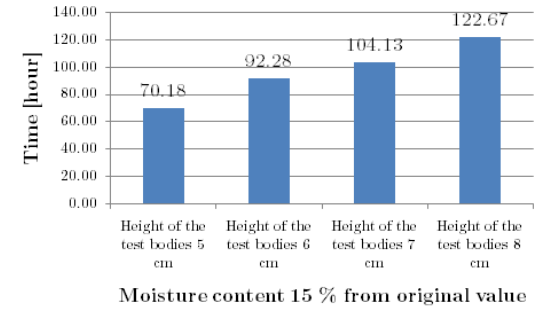
Figure 14. The decrease by 85 % from original value of the moisture content.